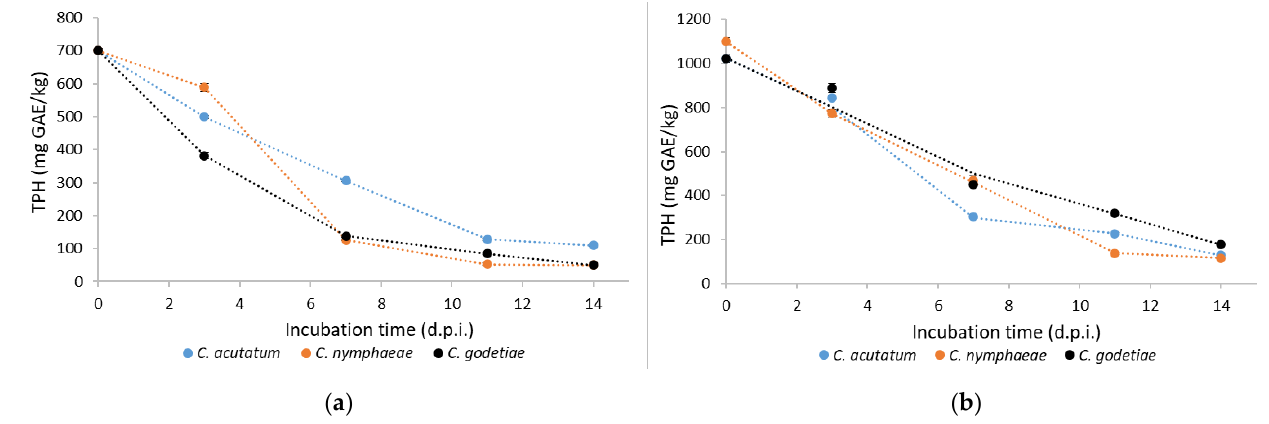
Figure 6. Total phenolic content (TPH), expressed in mg of gallic acid equivalent per kg of VOO (mg GAE/kg) in Galega ( a ) and Cobrançosa VOO ( b ) extracted from fruits inoculated with Colletotrichum acutatum , C. nymphaeae, and C. godetiae , at times 0, 3, 7, 11, and 14 days post-inoculation (d.p.i.) (mean values ± STD; STD variation range: 2.47–20.59; hardly seen in the figures).